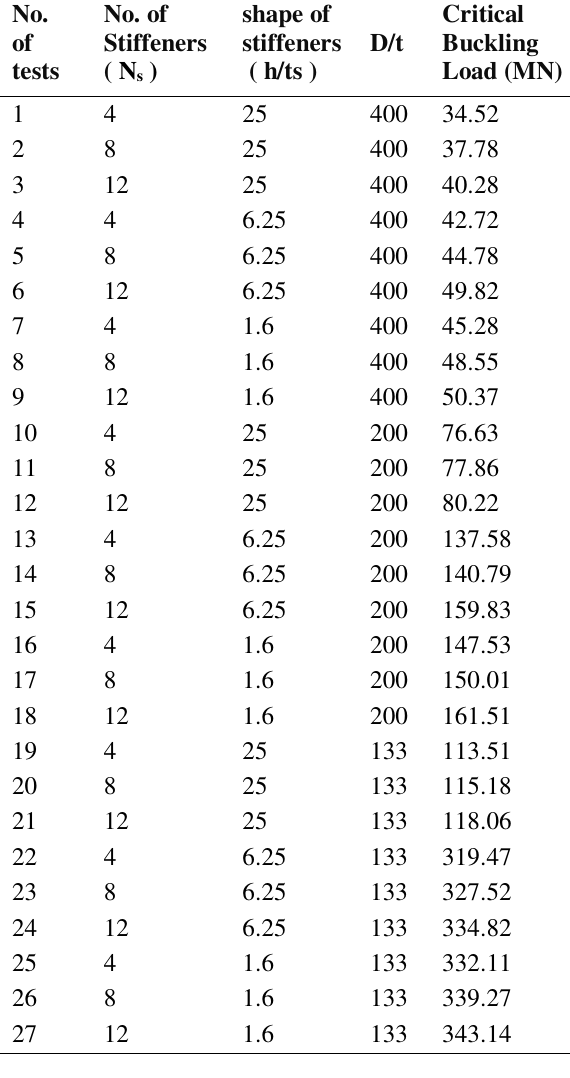
Fig. 4. The variation of critical load with parameters at constant